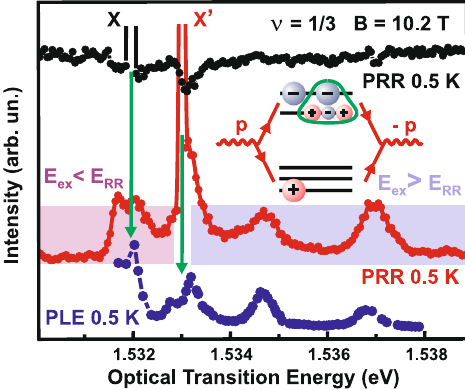
Fig. 4 Spectra of photoinduced resonant re fl ection. The spectra of PRR are obtained by varying the wavelength of the fi rst radiation source used to create excitations, given a fi xed wavelength and power level of the probing (second) source. Black and red dots indicate, respectively, a standard channel of elastic light scattering and the nonstandard one where the amplitude is growing with the formation of neutral excitations. In the latter case, the enhanced response is observed at different photon energies of the fi rst source. The inset illustrates a possible process of elastic light scattering in the nonstandard channel. The resonances for exciting the electron system are obtained from the photoexcitation spectra (blue dots and the solid line below, PLE photoluminescence excitations). X and X ′ are laser positions of the probing laser for the standard and nonstandard elastic light scattering channels (pointed by the green arrows for convenience). Laser power is 10 μ W at the excitation spot size of 100 μ m. E ex and E rr stand for excitation energy and resonant re fl ection energy, respectively.